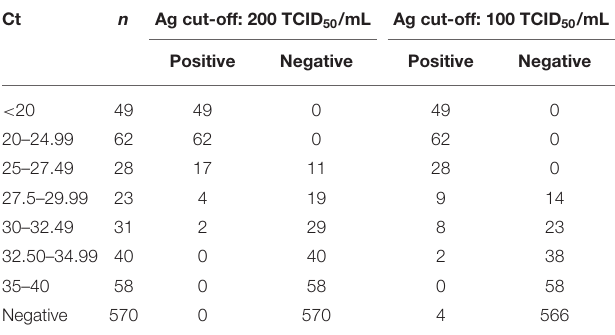
TABLE 2 | Sample distribution according to Ct and Ag results by using two different cutoffs > 200 TCID 50 /ml and > 100 TCID 50 /ml previously classified as undetermined cutoffs as described by the manufacturer (100–199 TCID 50